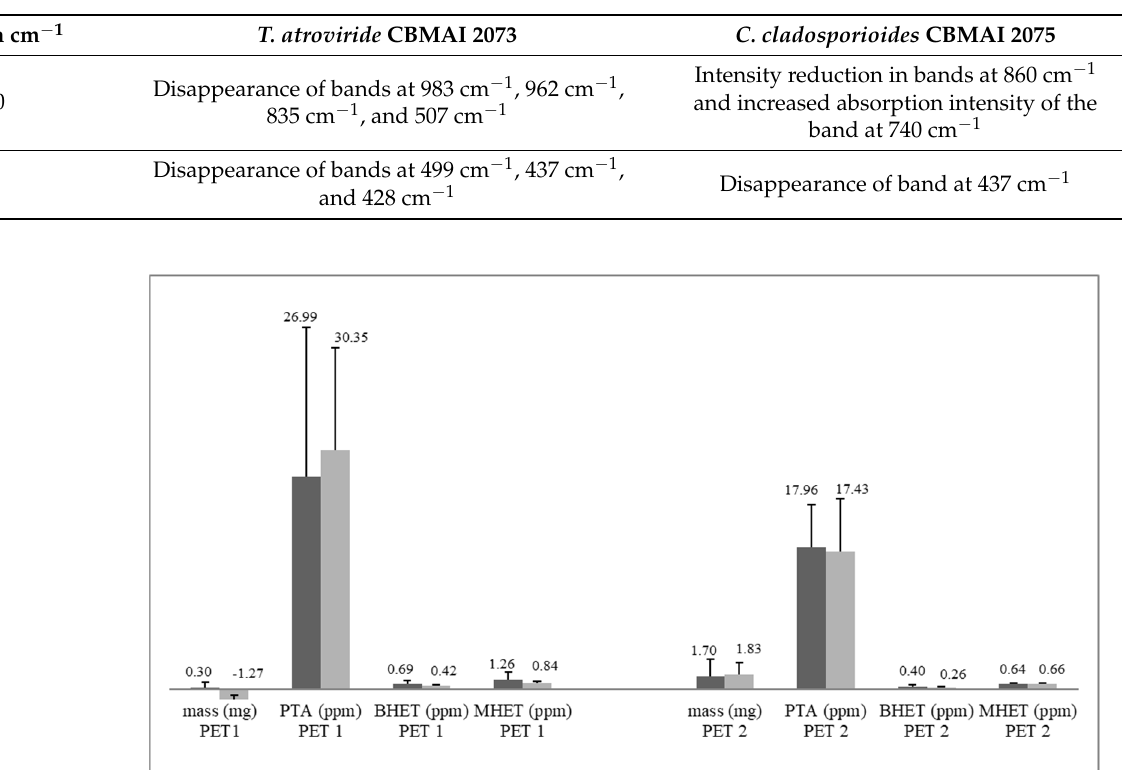
Figure 8. FTIR spectra of PET1 and PET2 polymers after 40 days in contact with T. atroviride CBMAI 2073 and C. cladosporioides CBMAI 2075. Note. Culture media PDB, t = 28 °C, shaking at 150 rpm.